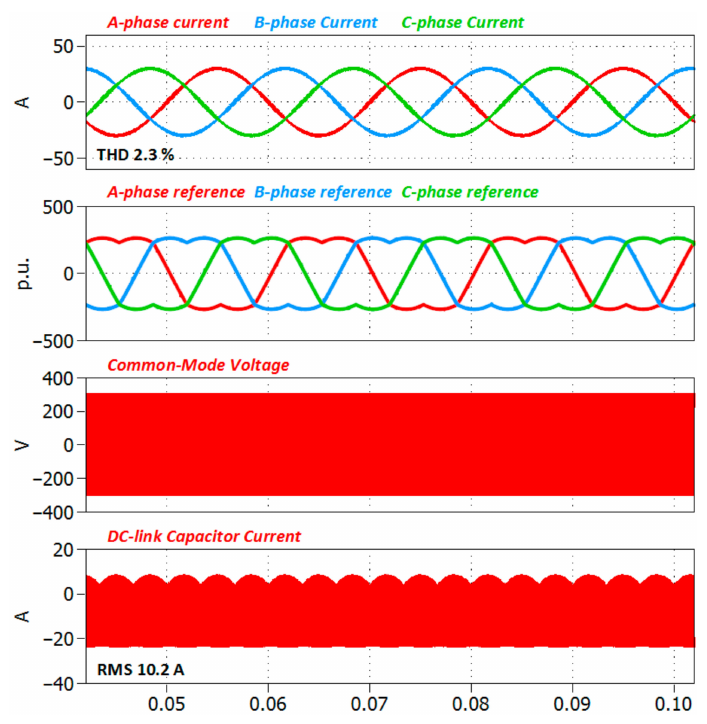
Figure 6. Simulation results of the conventional DPWM.